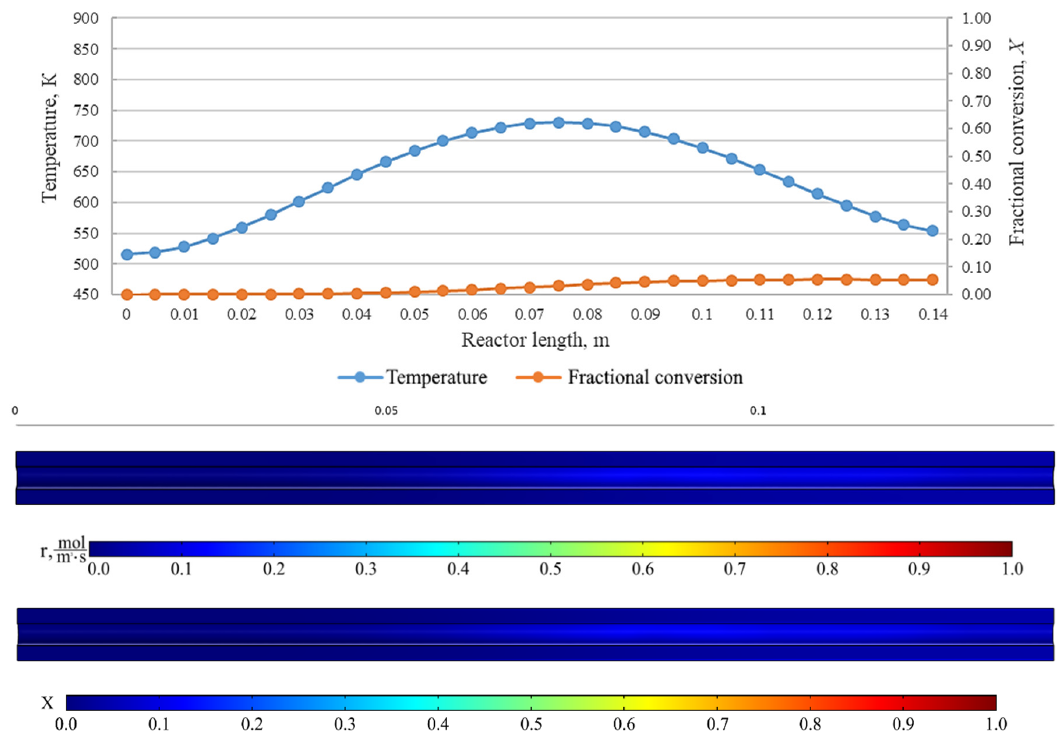
Figure 19. From top to bottom: temperature and fractional conversion curves, profiles of the reaction rate and fractional conversion along the reactor length for the experiment cyGOm_450_127 (Tmax = 450 °С , 𝑉(cid:4662) = 1.0 L/min).